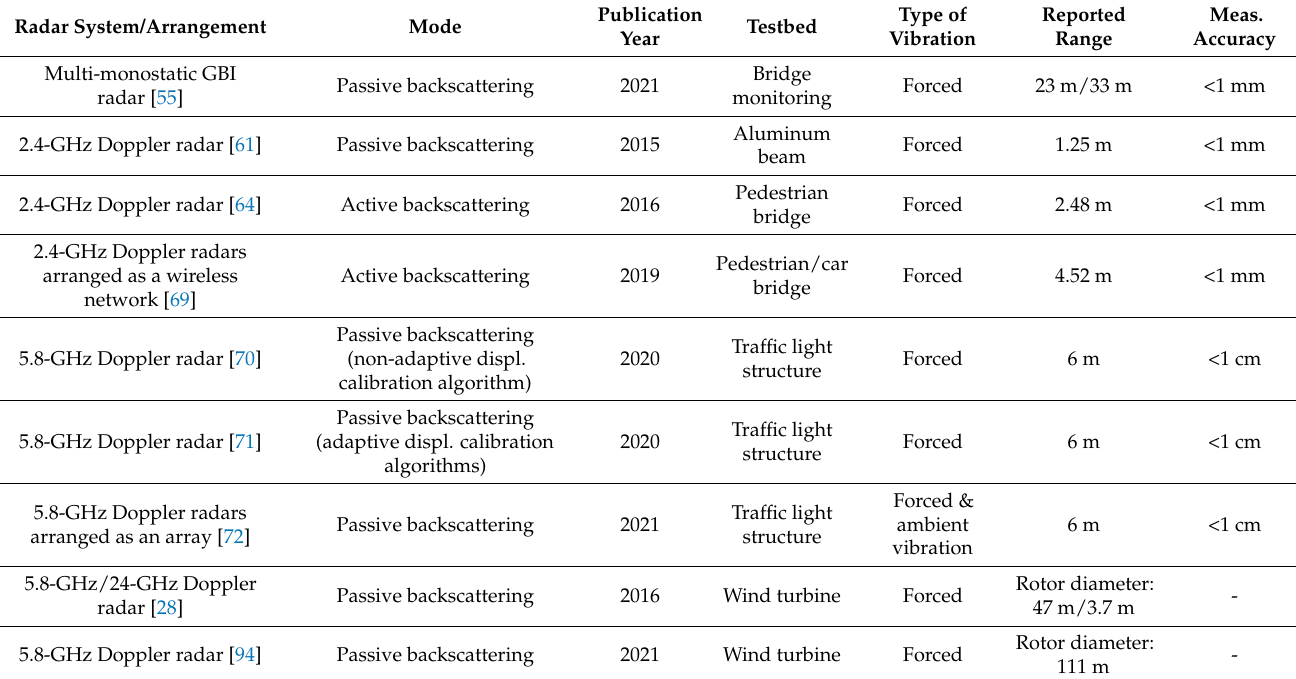
Figure 14. Spectrogram for a faulty three-blade wind turbine obtained from 5.8-GHz Doppler radar measurements. Reprinted with the permission from ref. [94]. Copyright 2021 IEEE. Table 1. Summary list of the research works reviewed in this